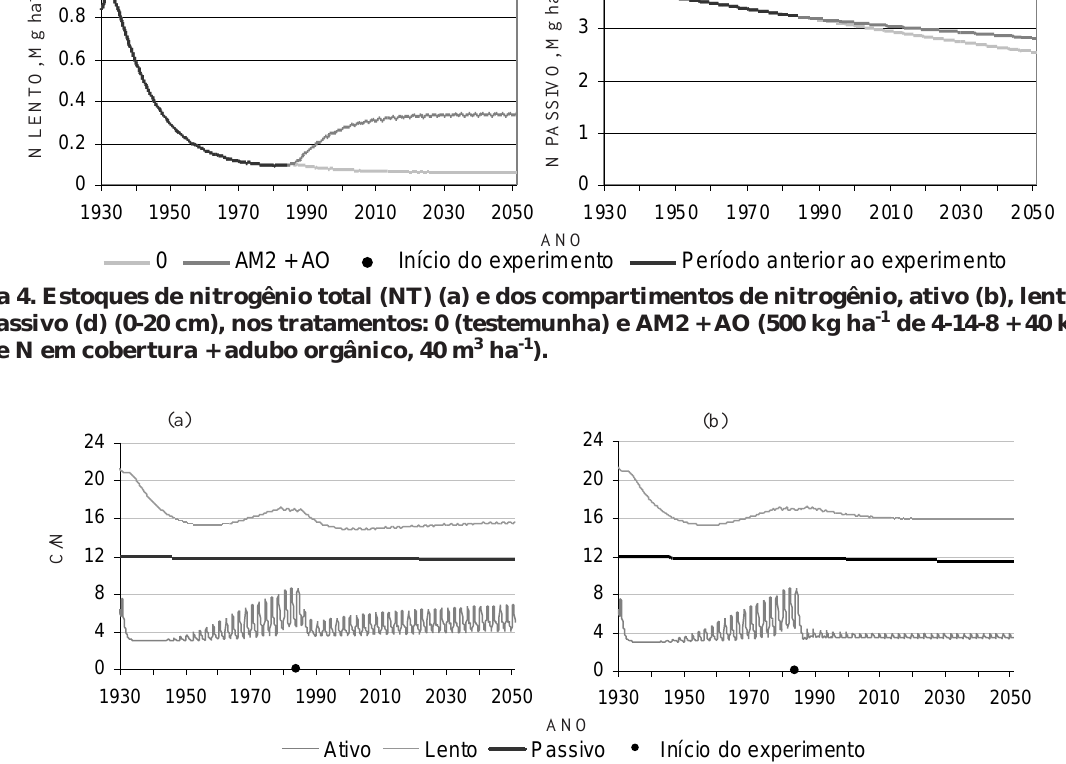
Figura 5. Relação C/N nos compartimentos de nitrogênio, ativo, lento e passivo, nos tratamentos: 0 (testemunha) (A) e AM2 + AO (500 kg ha -1 de 4-14-8 + 40 kg ha -1 de N em cobertura + adubo orgânico, 40 m 3 ha -1 )